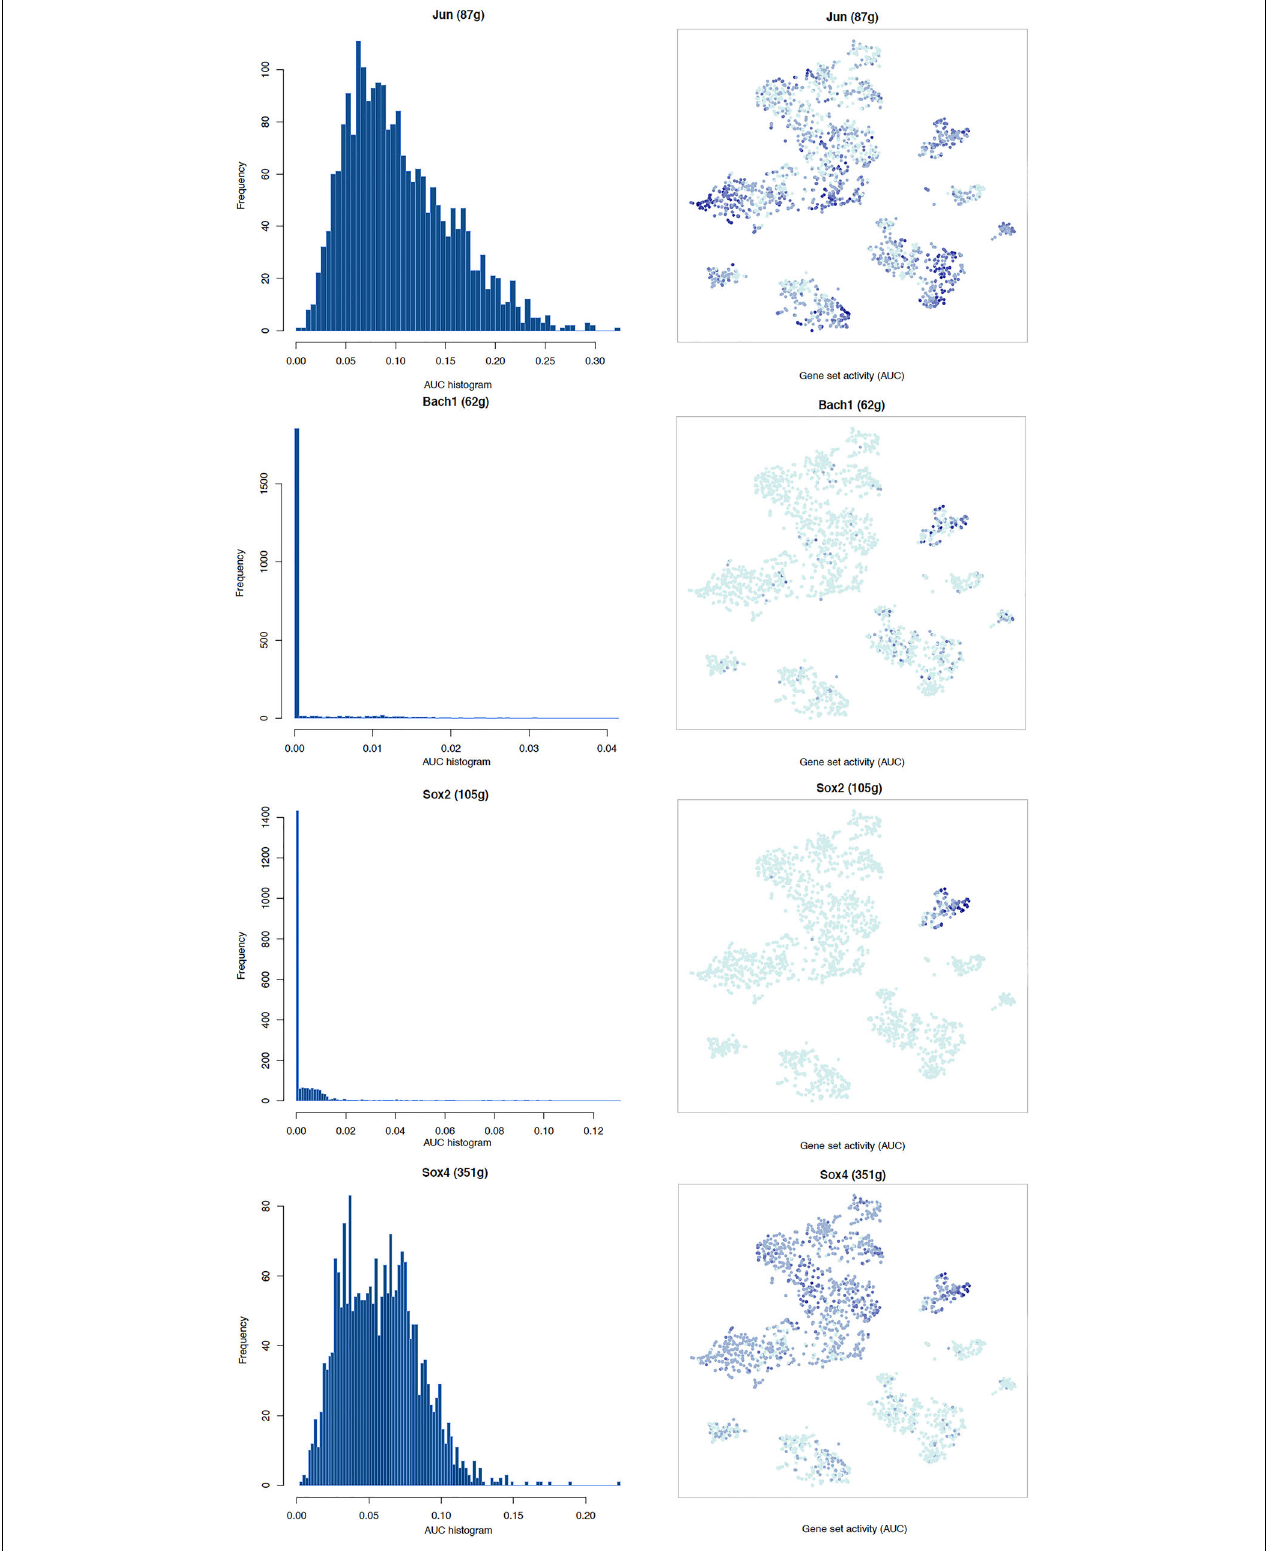
FIGURE 6 | tSNE plots overlayed with regulon activity and histograms showing the distribution of regulon activity of Jun, Bach1, Sox2, and Sox4 in day 3 scRNA-seq data set.